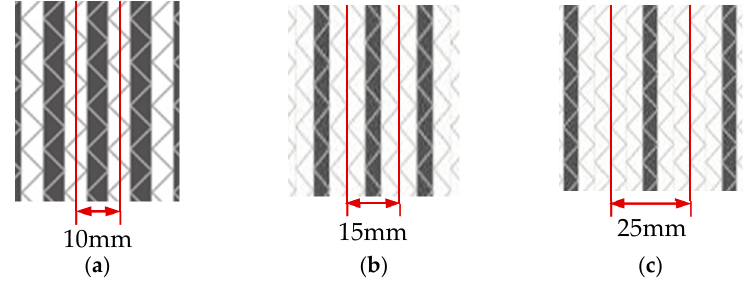
Figure 2. Schematics of sample cutting: ( a ) [C–G]; ( b ) [C–G–G]; ( c ) [C–G–G–G–G].